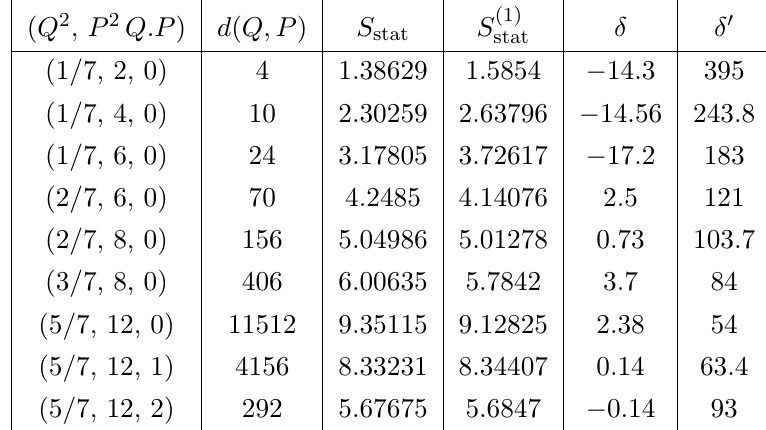
Table 14 . Comparison of the statistical entropy and statistical entropy at one loop for 14A/B orbifold.